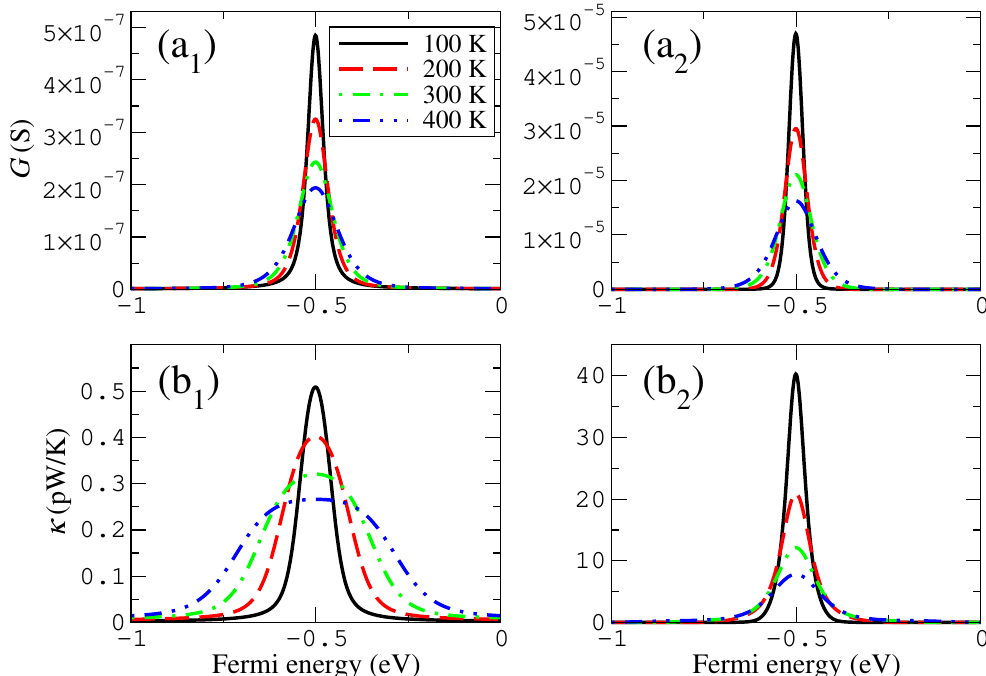
Figure 4. Temperature dependence of the electronic ( a ) and thermal ( b ) conductances for the wedge– edge (1) and wedge–wedge (2) configurations. The coupling parameter in this case is − 0.2 eV. Notice that the vertical axis intervals in panels (1) and (2) are